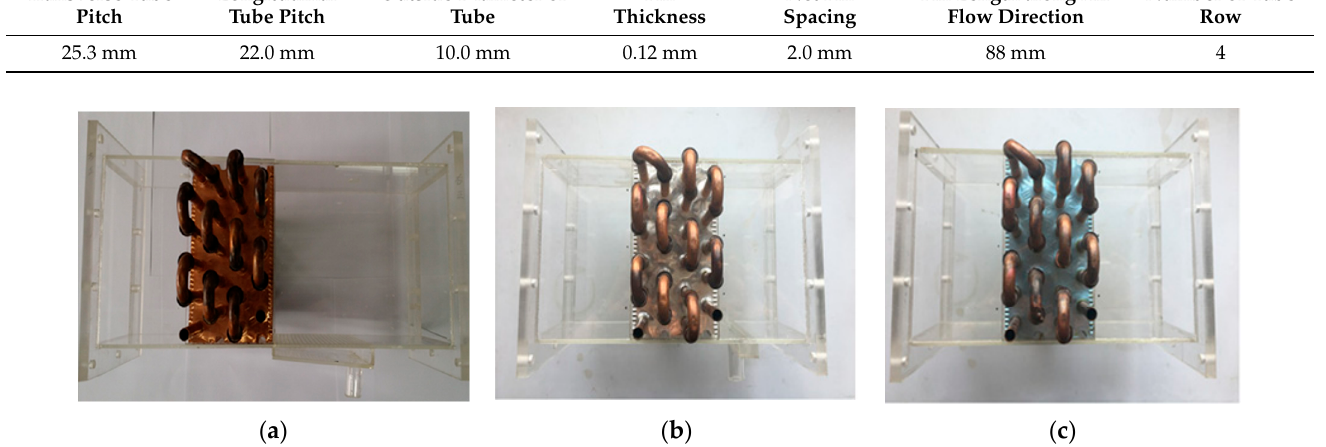
Figure 2. Test specimens: ( a ) copper fin, ( b ) aluminum fin, ( c ) aluminum fin with a hydrophilic layer.